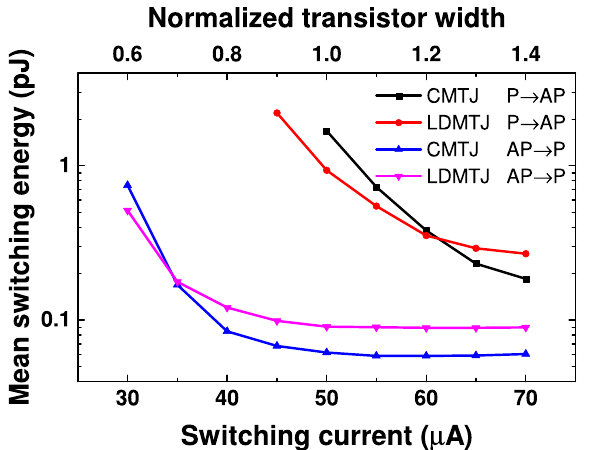
Figure 4. Mean switching energy of the CMTJ and LDMTJ devices. Each point on the plot is averaged over 1000 simulations.Top axis shows the effective transistor width normalized to the width required to maintain the current of 50